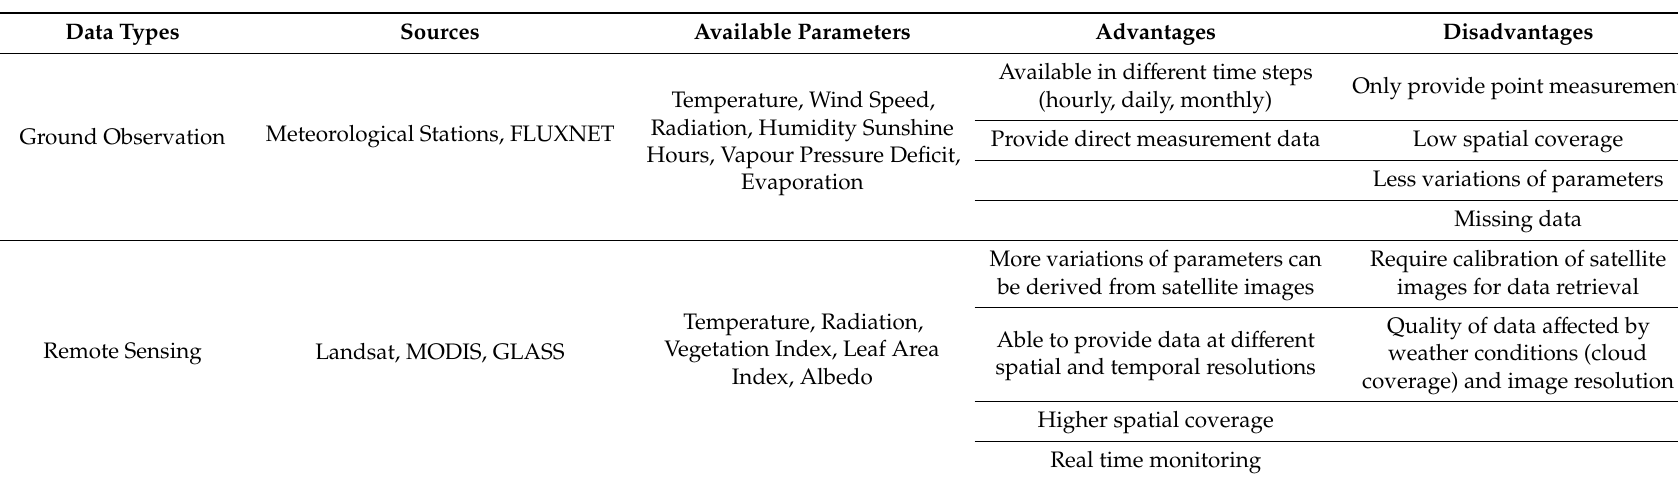
Table 2. Types of data for evapotranspiration